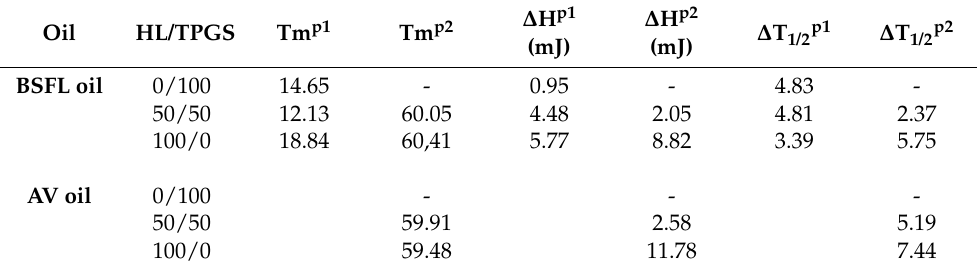
Figure 2. Effects of surfactant ratio of HL/TPGS on endothermal DSC diagrams of ( a ) AV oil NEs and ( b ) BSFL-NEs encapsulated with Apig at SOR 60% and oil 1%. Table 2. Enthalpy changes ( ∆ H), main transition temperature ( ∆ Tm), and half-width transition temperature ( ∆ T 1/2 ) of BSFL oil and AV oil nanoemulsions encapsulated with Apig under SOR = 60% and different surfactant ratios of HL/TPGS on P1 and P2 phase transition regions obtained from endothermal DSC